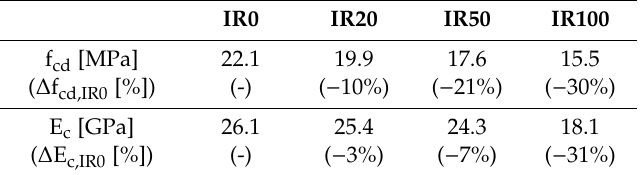
Table 5. Design compressive strength and modulus of elasticity of each